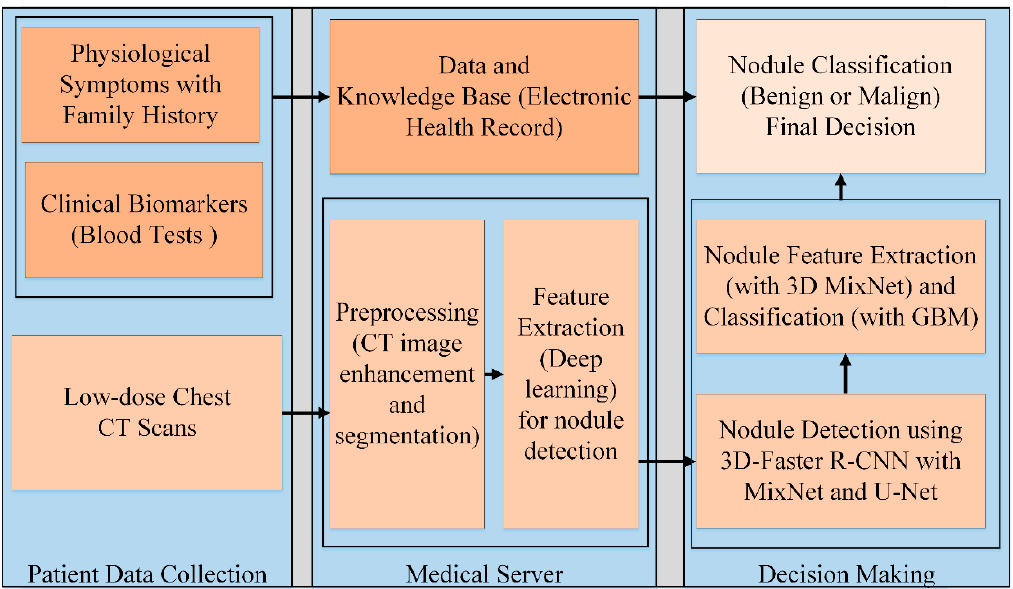
Figure 3. Block diagram of the proposed lung nodule detection and classification system.